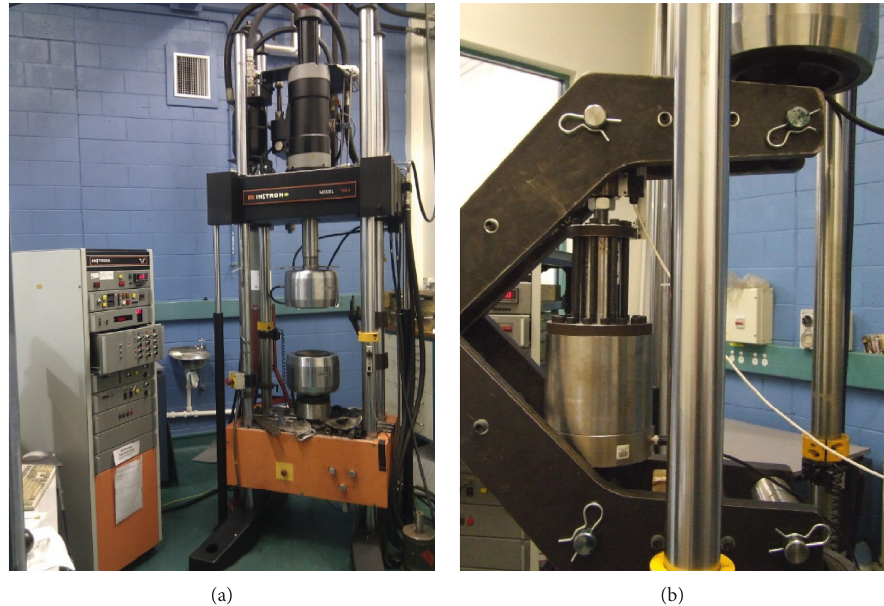
Figure 3: Details of the device test configuration. (a) Instron 1344 at Quest Integrity Ltd, Gracefield. (b) Lever system to increase force